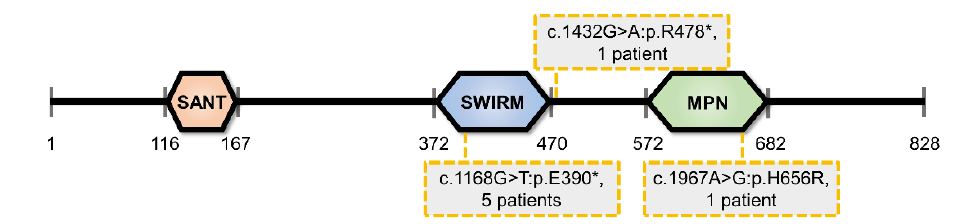
Figure 1. MYSM1 Protein: Domain Structure and Mutations in Human Patients. MYSM1 comprises SANT, SWIRM, and MPN domains. MYSM1 mutations reported in human MYSM1-deficiency syndrome patients include the p.H656R substitution within the critical JAMM-motif of the catalytic domain, and the nonsense variants p.E390* and p.Arg478* truncating MYSM1 protein upstream of the catalytic domain. All mutations in the patients are in a homozygous state.